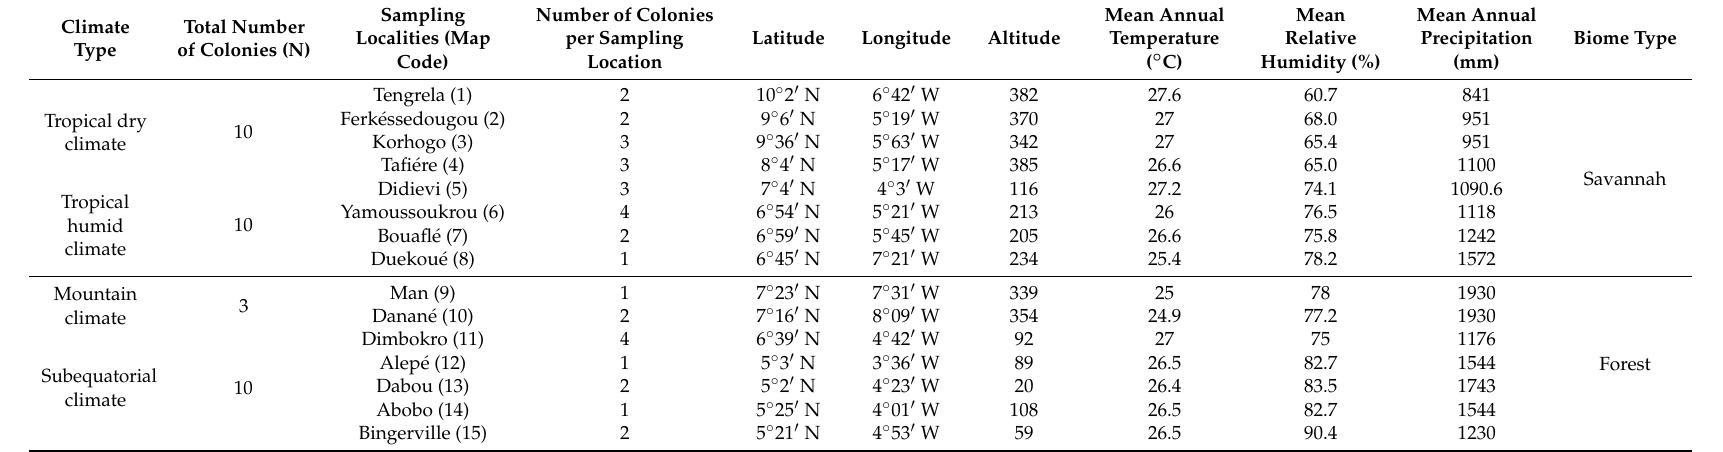
Table 1. Geo-coordinates, climatic conditions and landscape type of the sampling sites and